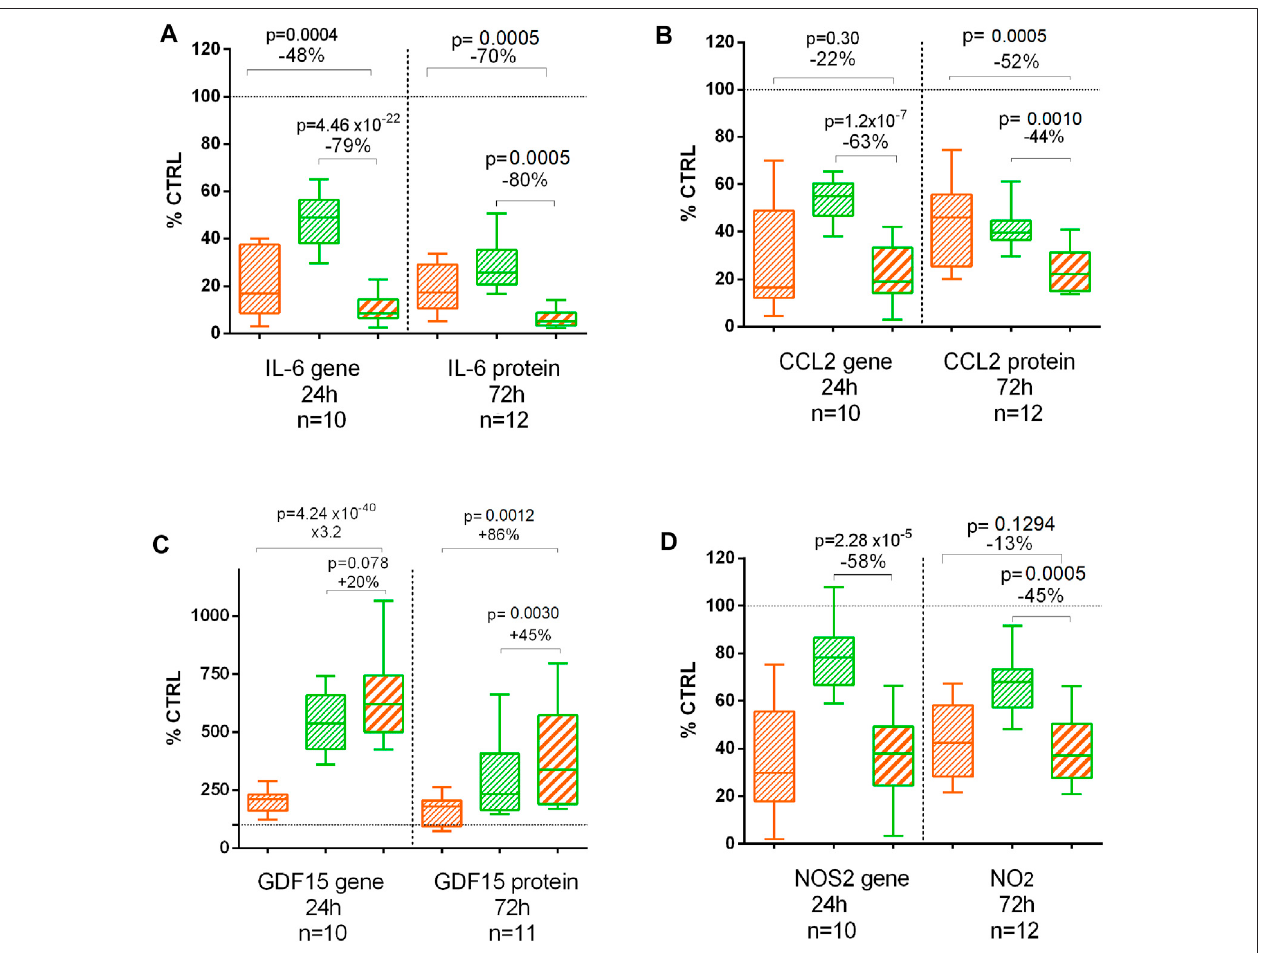
FIGURE 5 | Effect of C. longa 2 μ g/ml (orange), B. serrata 50 μ g/ml (green), and combination of C. longa and B. serrata on IL6 (A) , CCL2 (B) , GDF15 (C) , and NOS2/NO 2 (D) gene expression (RNA-seq at 24 h) and protein production (72 h).